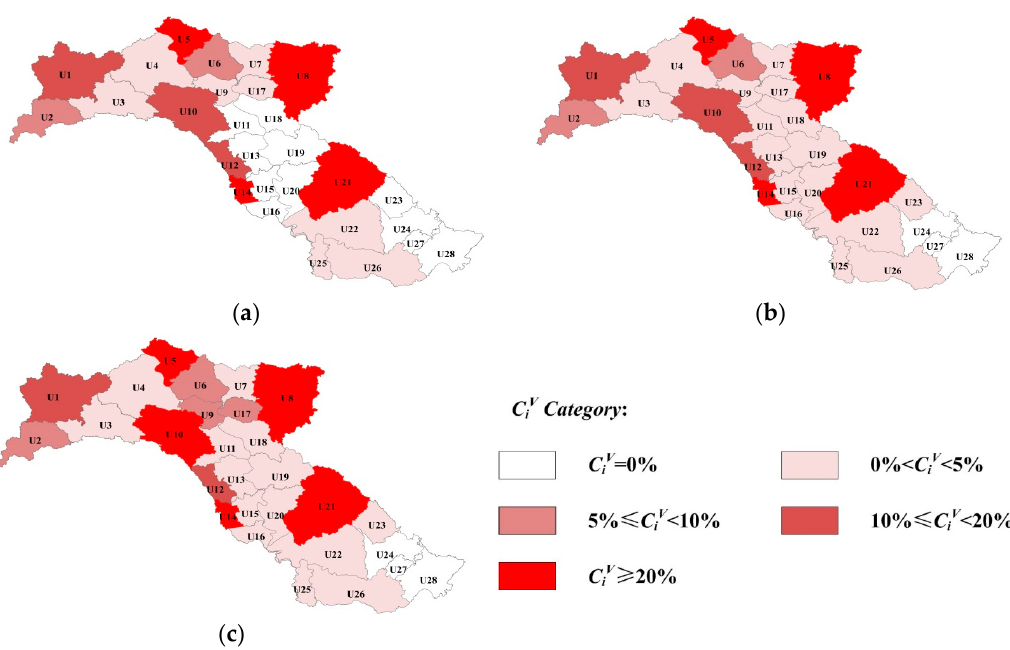
C categories in the MLHRB basin for different scenarios: ( a ) Figure 5. Spatial distribution of the V Figure 5. Spatial distribution of the C V categories in the MLHRB basin for different scenarios: i i present; ( b ) short ‐ term planning horizon; ( c ) long ‐ term planning horizon. ( a ) present; ( b ) short-term planning horizon; ( c ) long-term planning